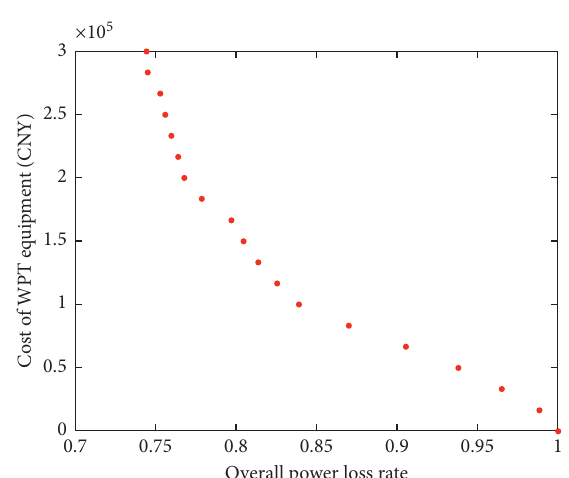
Figure 4: Last generation of the solution. Table 2: The selected solutions. Scheme